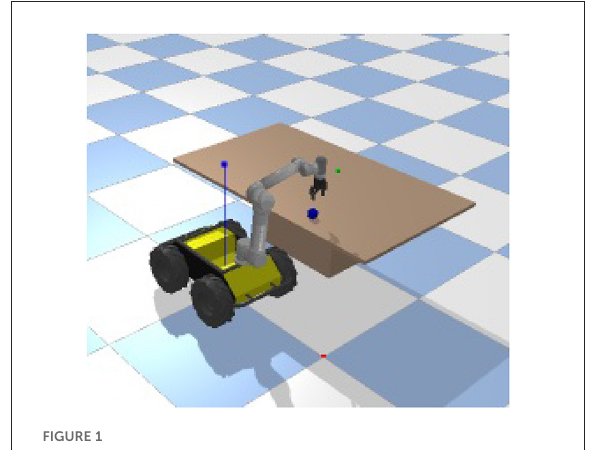
FIGURE1 Husky-UR5 reach and grasp